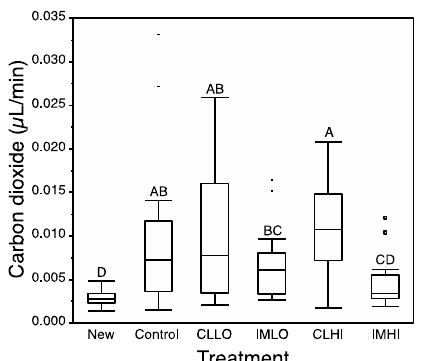
Figure 5. Median ( ± quartiles) volume of carbon dioxide ( µ L/min) emitted over 10 min by individual newly emerged honey bees, and by honey bees after two weeks exposure to two neonicotinoids. Treatment groups = Clothianidin Low (CLLO) and High (CLHI) dose treatments; Imidacloprid Low (IMLO) and High (IMHI) dose treatments. Letters above bars represent significant differences across treatments from multiple comparison Wilcoxon post hoc tests.